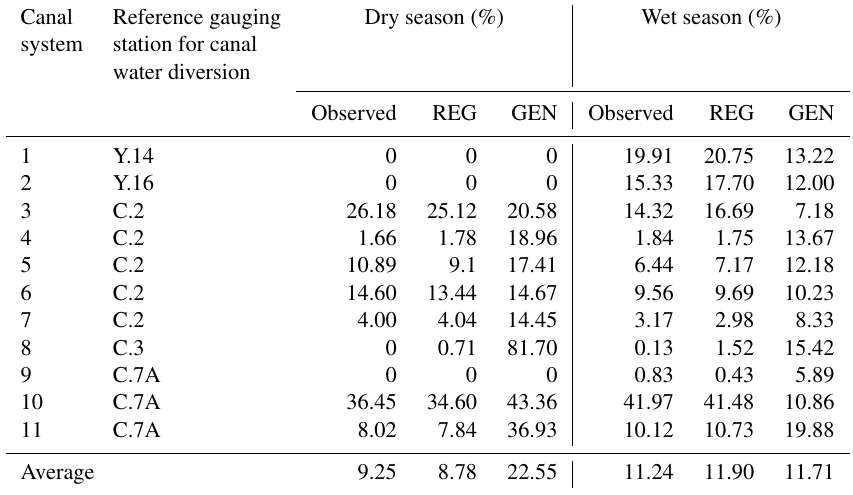
Table 4. The observed and simulated fractions of diverted river flow to the canals under regionalized (REG) and generalized (GEN) canal schemes during the wet and dry